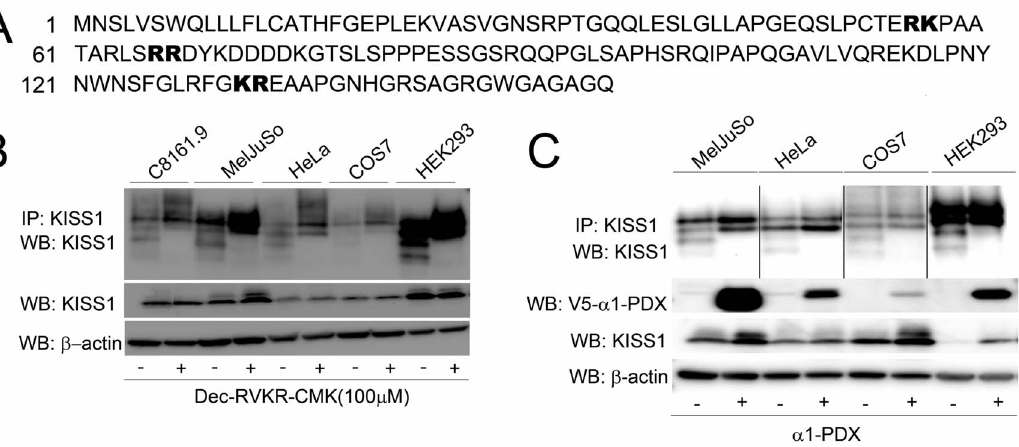
Figure 2. Proprotein convertases are required for KISS1 processing. A. Amino acid sequence of KISS1 showing three predicted PC cleavage sites 2 RK, RR and KR in bold. Note: DYKDDDDK at position 68 is the FLAG epitope tag used for several of the studies described in this manuscript. B. Treatment of C8161.9, MelJuSo, HeLa, COS7 and HEK293 cells over-expressing KISS1 with the general PC inhibitor Dec-RVKR-CMK (100 m M) blocked KISS1 processing as detected by immunoprecipitation and immunoblot using anti-KISS1 antibody [See Figure 1 and Materials and Methods for details]. C. Over-expression of KISS1 and the biological PC inhibitor V5-tagged a 1-PDX also resulted in loss of KISS1 processing into KP. Polypeptide sizes correspond to those shown in Figure 1.